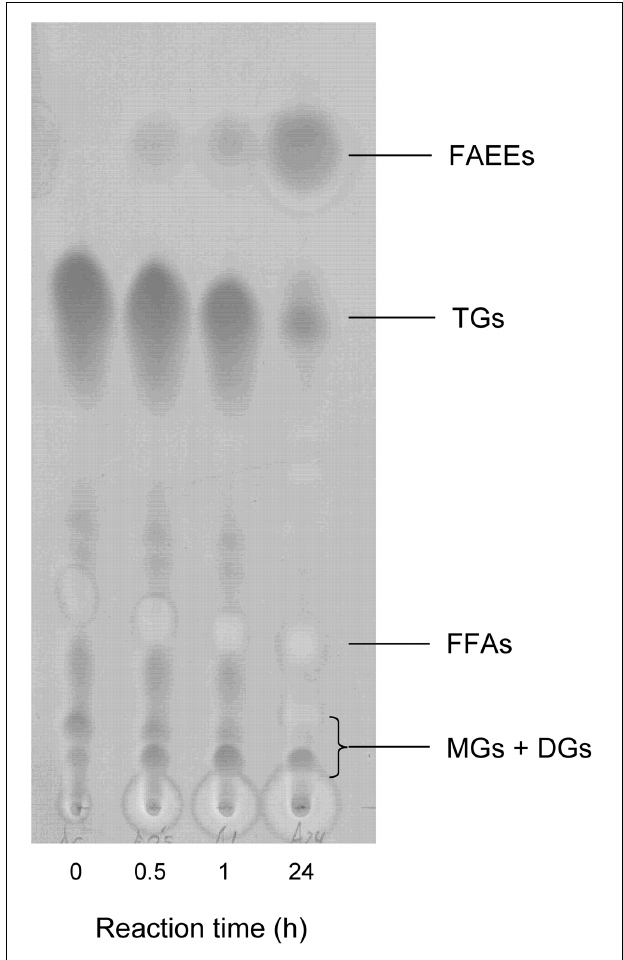
FIGURE 8 | Analysis by TLC of biodiesel (FAEEs) conversion from vegetable oils mixture using mCLEA-CALB. The reaction mixture containing 0.2g oil (80% palm oil, 10% soybean oil, and 10% olive oil), ethanol (30:1 alcohol:oil molar ratio) and 1% (w/w of oil) mCLEAs was incubated for 24h at 30 ◦ C with rotational mixing. Triglycerides (TGs), diglycerides (DGs), monoglycerides (MGs), and free-fatty acids (FFAs).